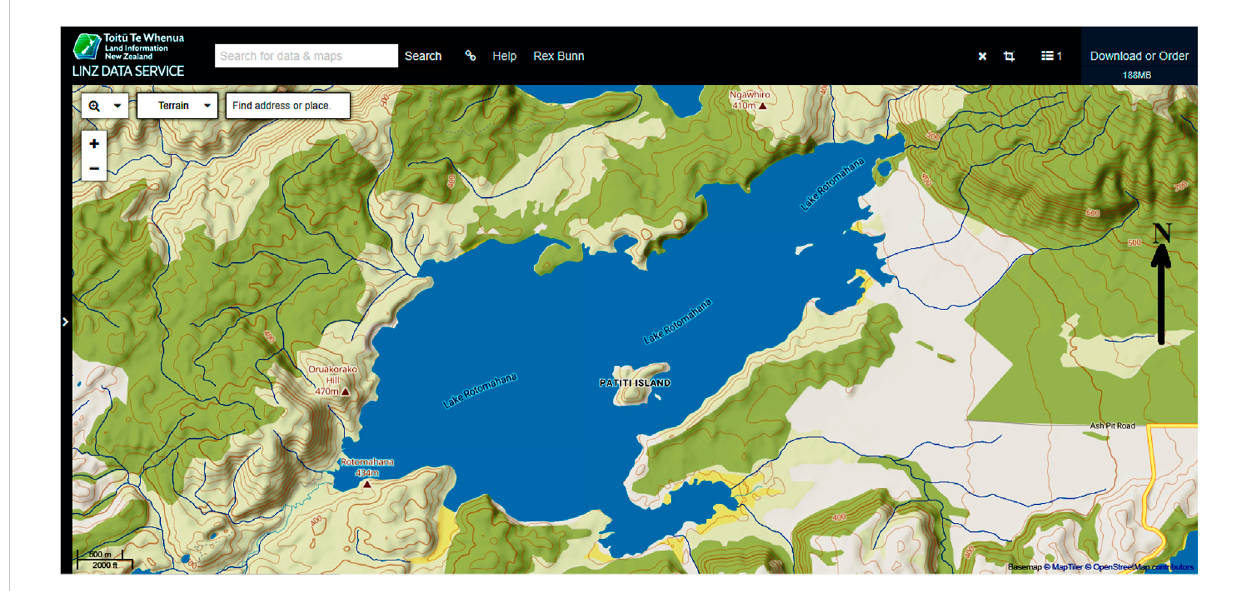
FIGURE 5 Rotomahana Basin topography detailing the post-eruption streams (New Zealand River Pilot). Refer to Figure 1 for location